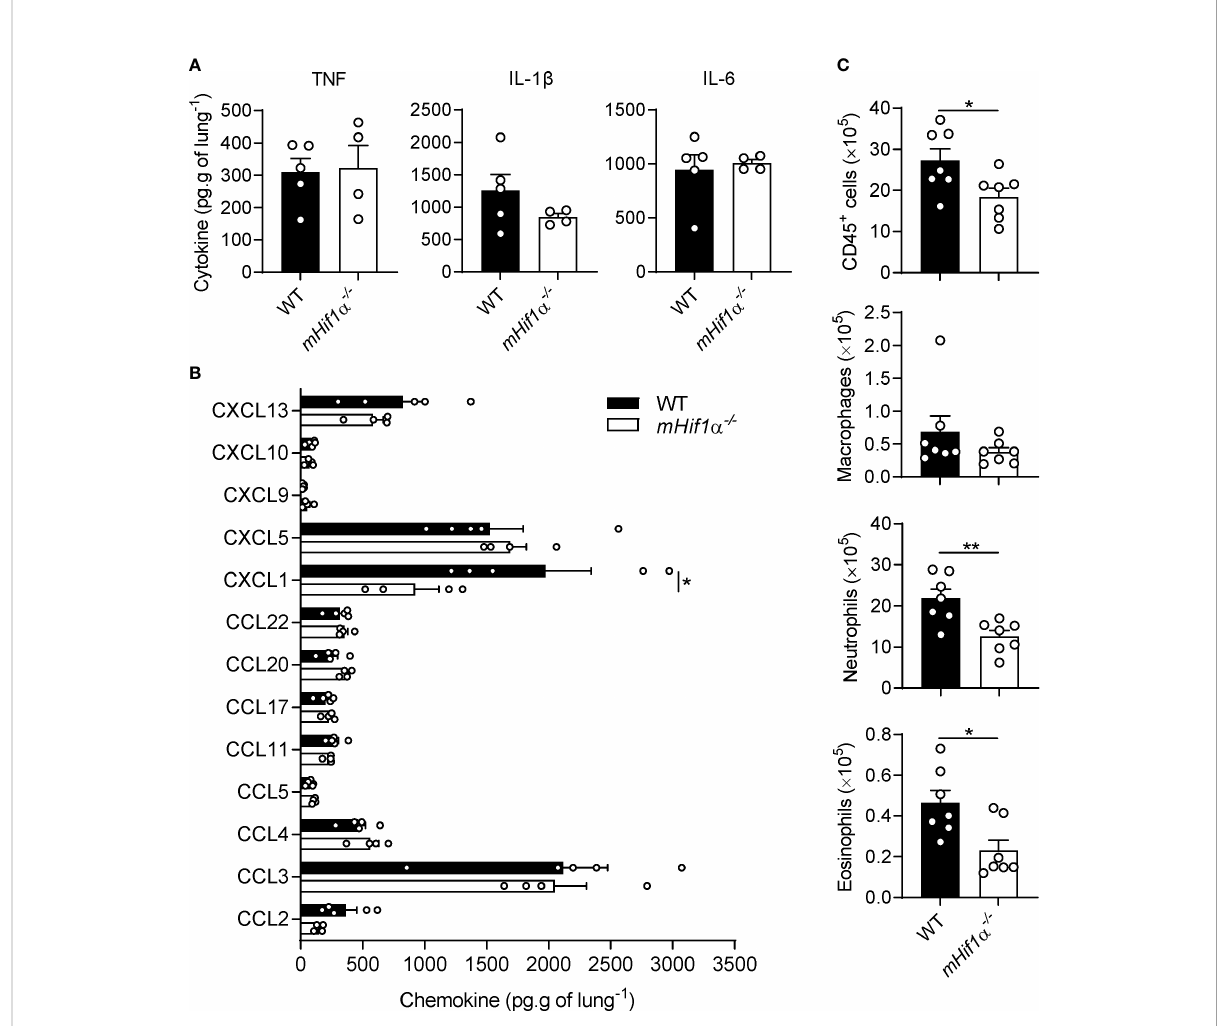
FIGURE 3 Immune cell recruitment is compromised in mHif1a -/- mice. (A) Levels of TNF, IL-1 b and IL-6 and (B) chemokines in the lungs of WT (n = 5) and mHif1 a -/- (n = 4) mice after 3 days post-infection. (C) Immune cell populations in the lungs of WT and mHif1 a -/- mice after 3 days post- infection (n = 7). *P < 0.05; **P <